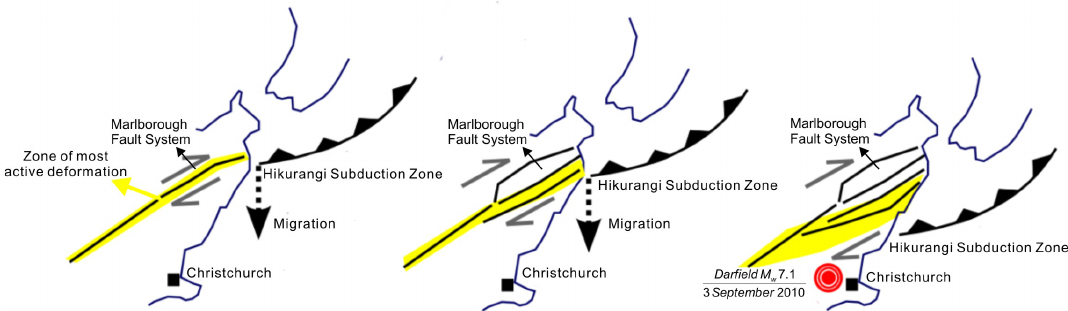
Fig. 2. A schematic plot of the southward migration of the Hikurangi Subduction Zone, causing new strands of the MFS to grow in order to accommodate more efficiently the plate motions (slightly modified from http://all-geo.org/highlyallochthonous/). This may be the reason why the earthquake sequence occurred away from the southern